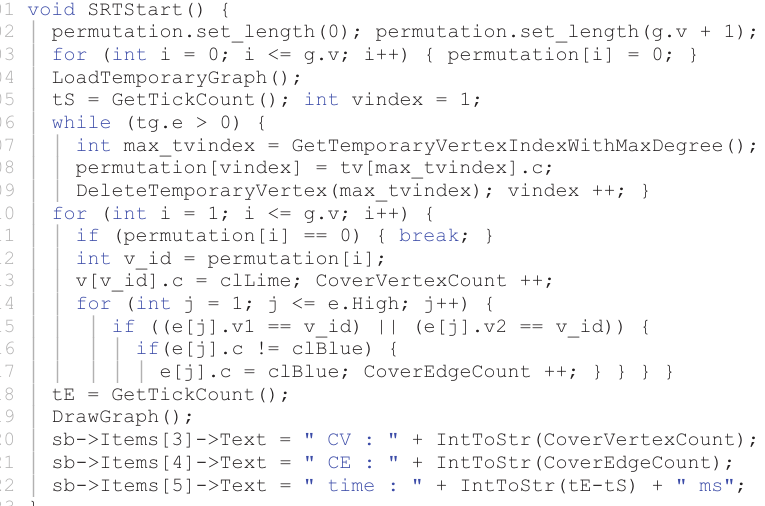
Fig. 4. The code of the SRT algorithm based on ordering the vertices according to their